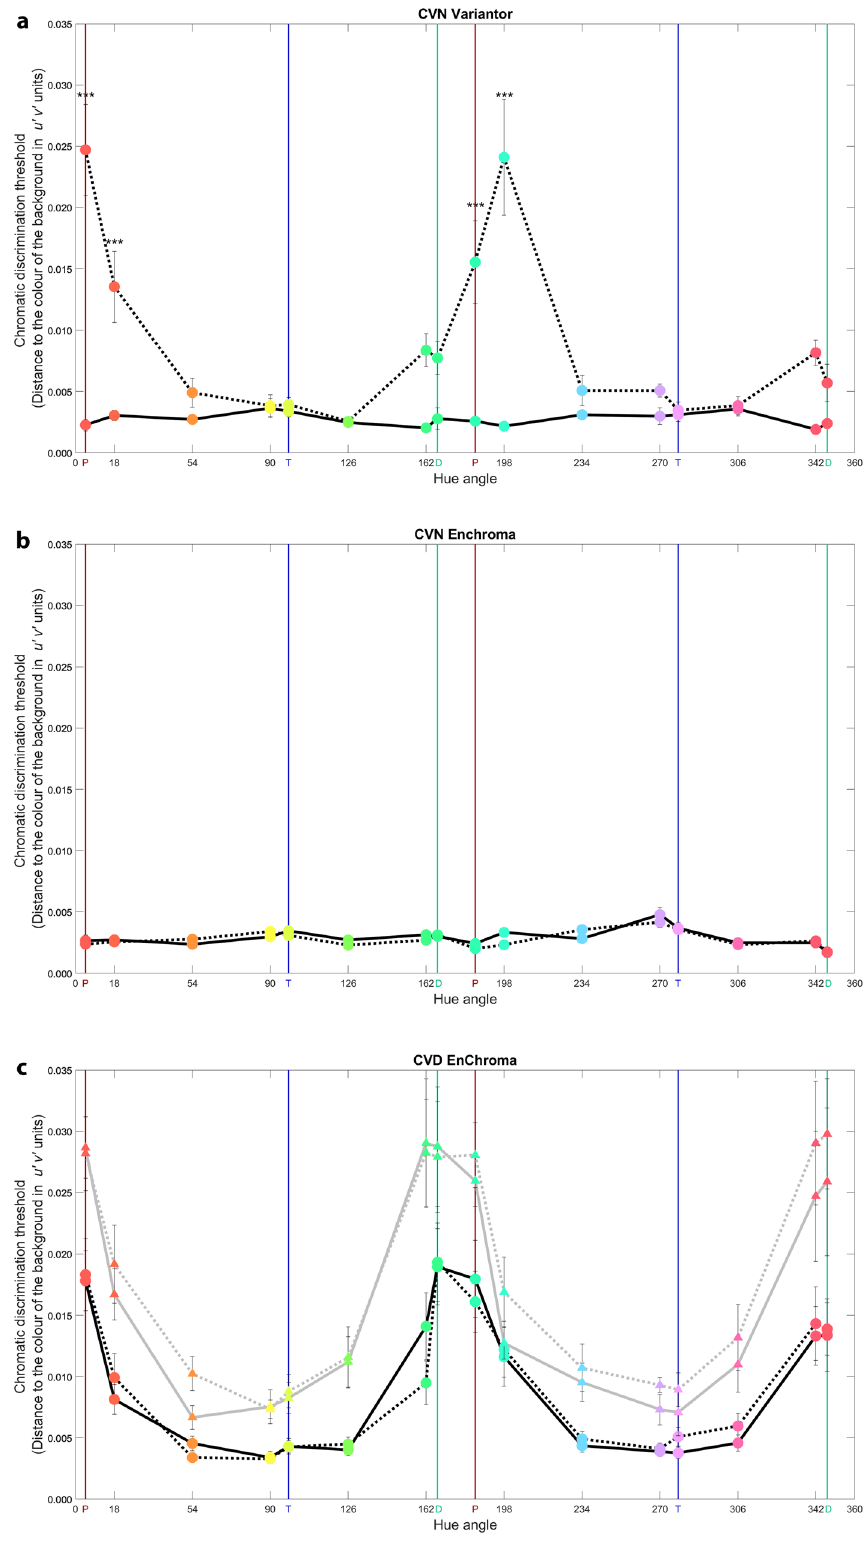
Figure 3. Mean discrimination thresholds for CVA-UMinho task, with and without filters. Discrimination threshold measures for the CVN-Variantor ( a ), the CVN-EnChroma ( b ) and the CVD-EnChroma ( c ) conditions without (solid) and with (dotted) filters with 5° (big circles along black lines) and 1° (small triangles along grey lines) stimuli. Marker colours are approximations of hues presented at maximum saturation. Vertical lines represent the two extremes of the protan (red), deutan (green) or tritan (blue) confusion lines. Error bars show ± 1 standard error of the mean (SEM). ***Indicates filter vs no-filter thresholds are significantly different by Tukey post-hoc testing (P <